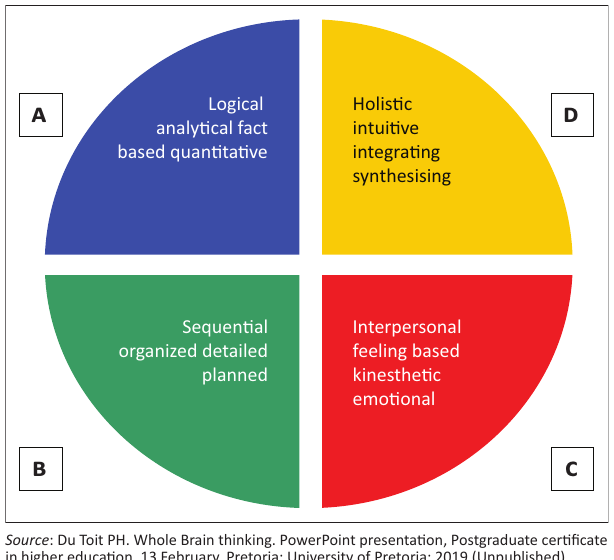
FIGURE 1: Simple representation of the metaphoric Whole Brain® Model.